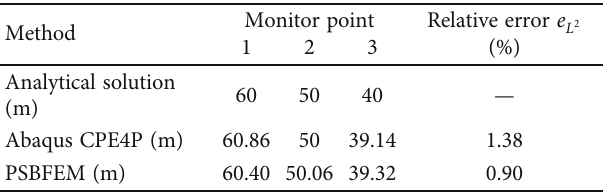
Figure 4: Steady-state seepage problem in a concrete dam: (a) geometric model and boundary conditions; (b) Abaqus CPE4P element; (c) PSBFEM polygonal element. Table 1: Comparison of the water head using di ff erent methods (element size